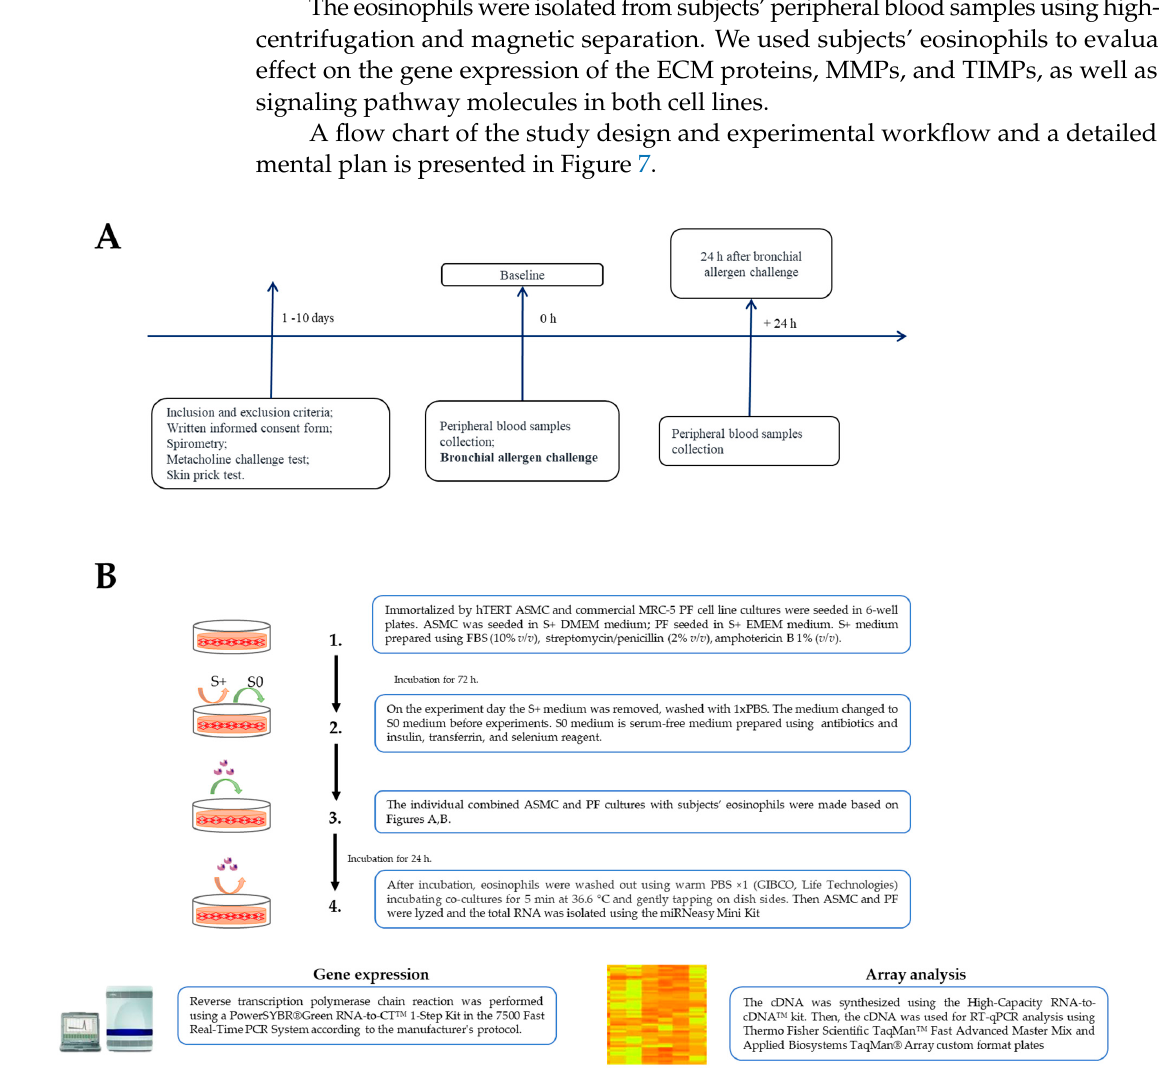
Figure 7. ( A ) ― The flowchart of the study design: recruitment of study subjects and clinical examination; ( B ) ― The experimental workflow.